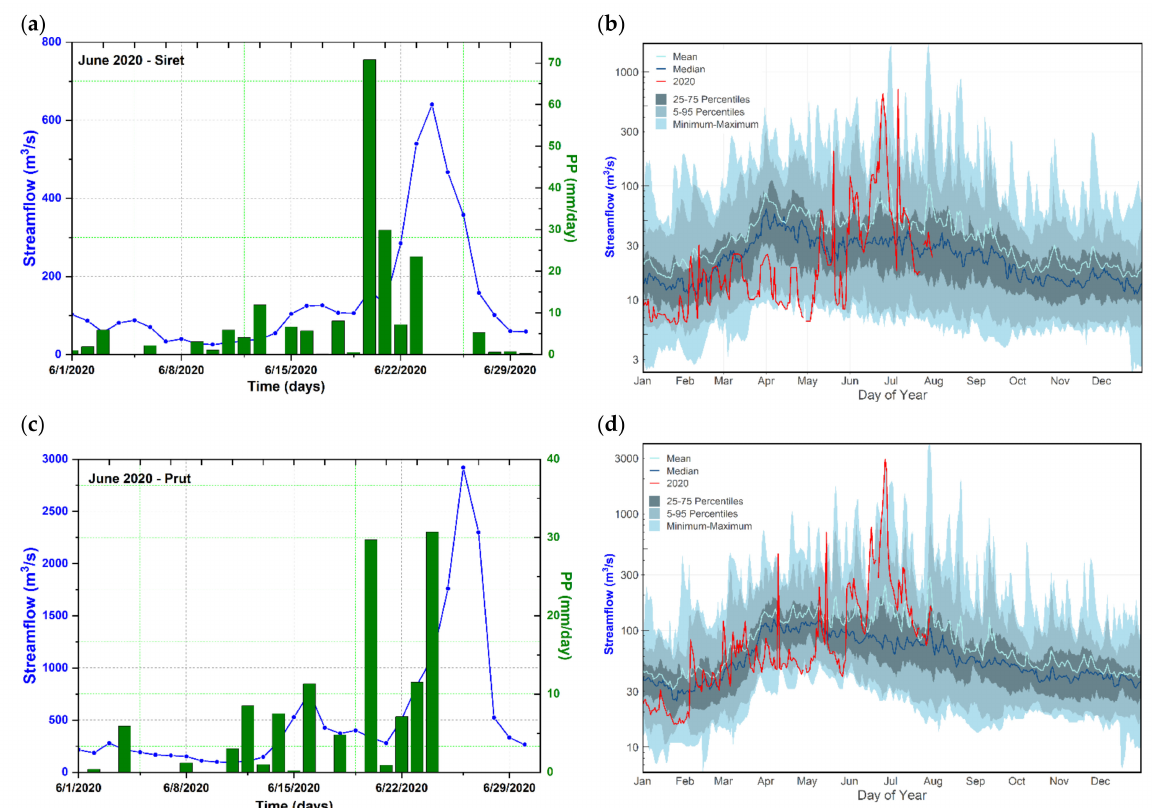
Figure 11. ( a ) Daily streamflow at Lespezi gauging station situated on the Siret River (blue line) and the precipitation amount at R ă d ă ut i meteorological station (green bars) for the period 1 June–30 June 2020; ( b ) The evolution of the flood peak in June , 2010 (red line) at Lespezi gauging station compared to the daily streamflow pattern on an annual basis (blue shaded line); ( c ) Daily streamflow at R ă d ă ut i-Prut gauging station situated on the Prut River (blue line) and the daily precipitation amount at , Darabani meteorological station (green bars) for the period 1 June–30 June 2020; ( d ) The evolution of the flood peak in June 2010 (red line) at R ă d ă ut i-Prut gauging station compared to the daily streamflow pattern on an annual basis (blue shaded area). , For the location of the gauging and meteorological stations, see Figure 1. The period 1981–2000 was used to compute the daily streamflow climatology in ( b , d ). For 2020 streamflow data was available just for the period 1 January 2020–31 July